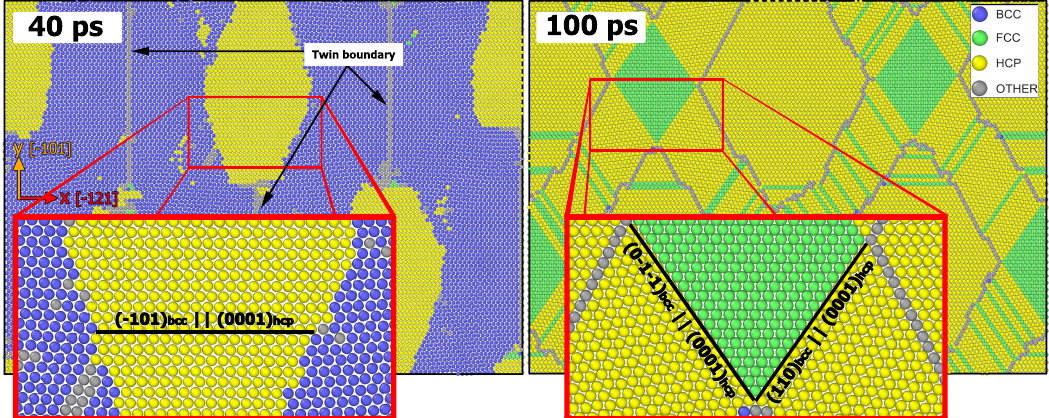
Figure 7. Snapshot of the ( ¯101 ) plane of a single-crystal containing 4 coherent twin boundaries at a strain of 4% and 10% (40 ps and 100 ps) on the left and the right, respectively. Atoms are colored according to crystal structure types (blue, bcc; green, fcc; yellow, hcp; grey, disordered